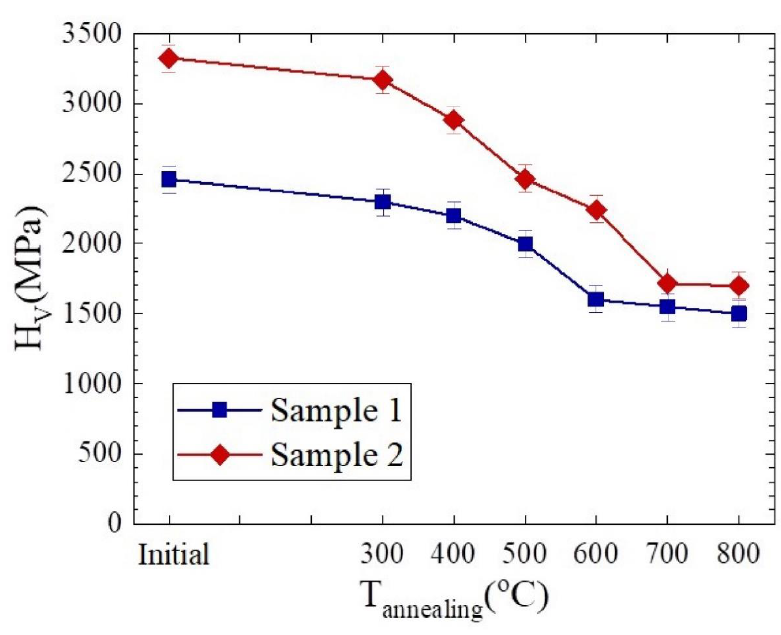
Figure 5. Microhardness of Samples 1 ( ■ ) and 2 ( ♦ ) of Cu – 18Nb composites versus the annealing temperature. In the range from room temperature to 300 °C, the microhardness of both samples